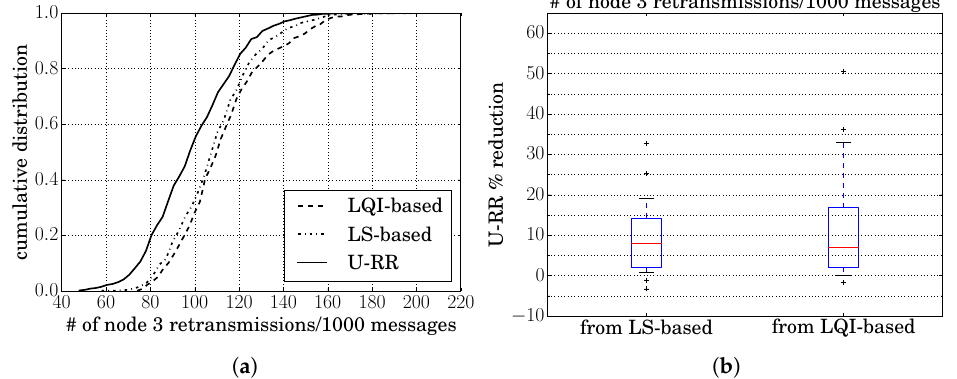
Figure 14. ( a ): Cumulative distribution of the number of node 3 retransmissions per 1000 messages generated. ( b ): Boxplots of the percentage reduction in the number of node 3 retransmissions per 1000 messages generated obtained by the U-RR procedure when compared to the LQI-based and the LS-based